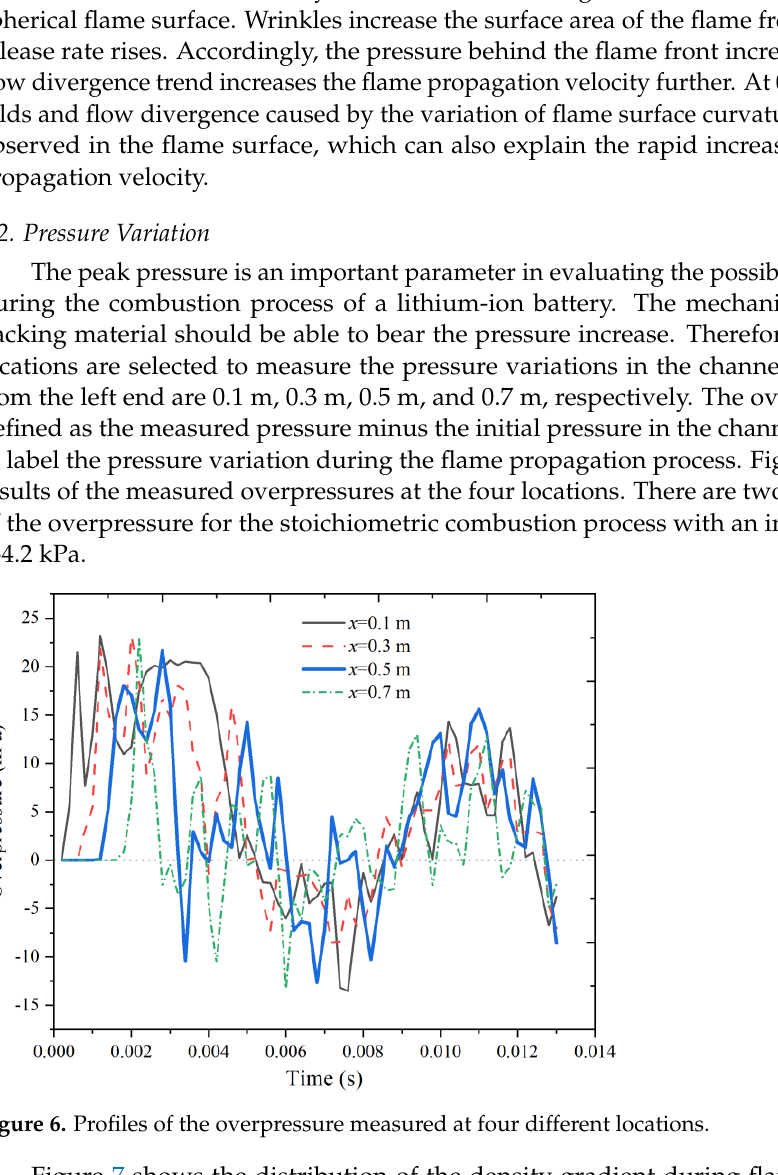
Figure 7. Results of the density gradient for the stoichiometric mixture during flame propagation.